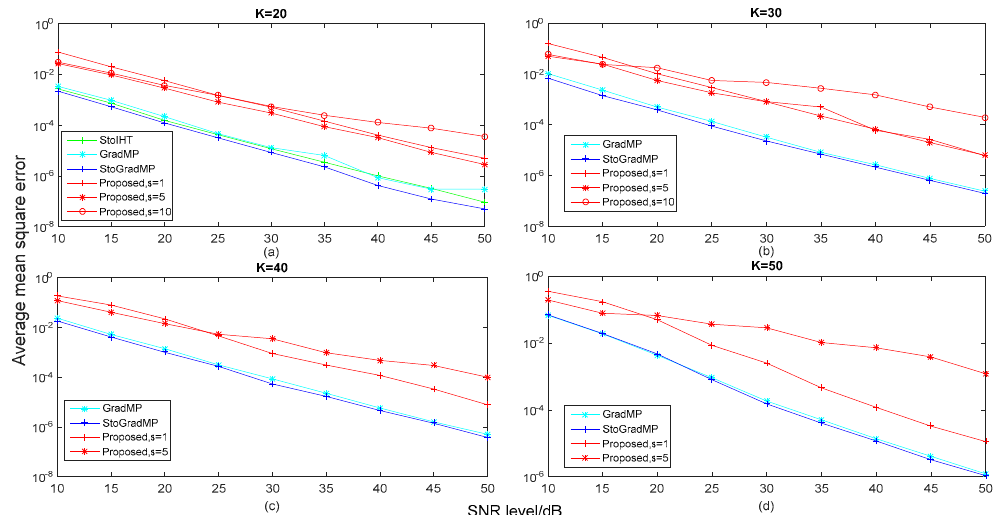
Figure 9. The average mean square error of different algorithms with different SNR levels in different real sparsity conditions ( n = 400, s ∈ [ 1,5,10 ] , δ K = 0.1 and m = 170, SNR = 10 : 5 : 50, Gaussian signal).